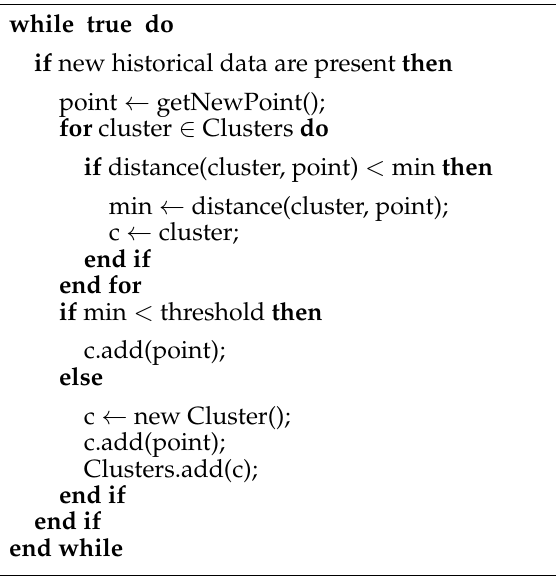
Algorithm 2 The incremental clustering